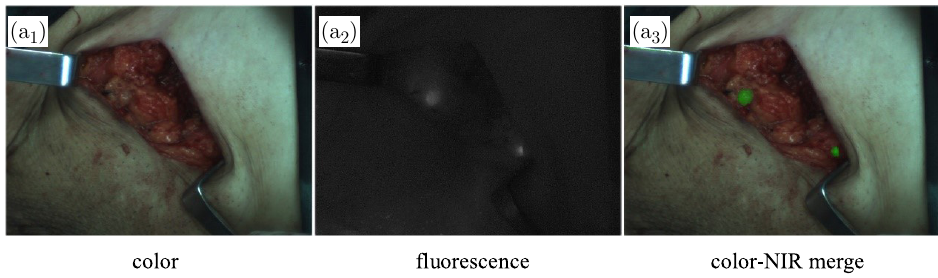
Fig. 7. Residual tissue with °uorescence or pseudo-color markers after SLNs